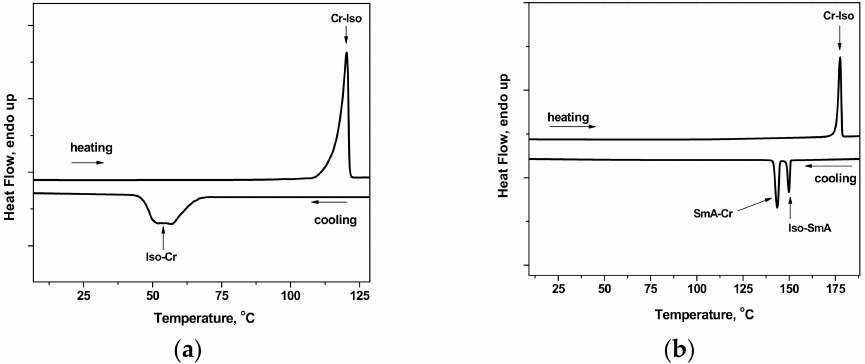
Figure 4. The second differential scanning calorimetry (DSC) heating–cooling cycles for compounds 2b ( a ) and 5b ( b